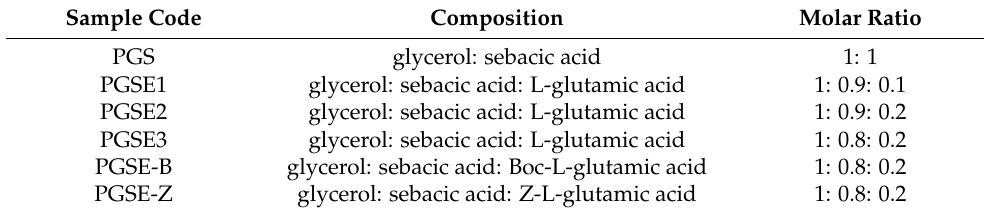
Table 1. Feed ratio of the